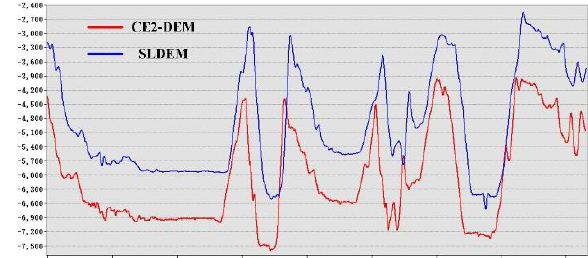
Figure 5. Profile comparison between the Chang’E-2 DEM and SLDEM.